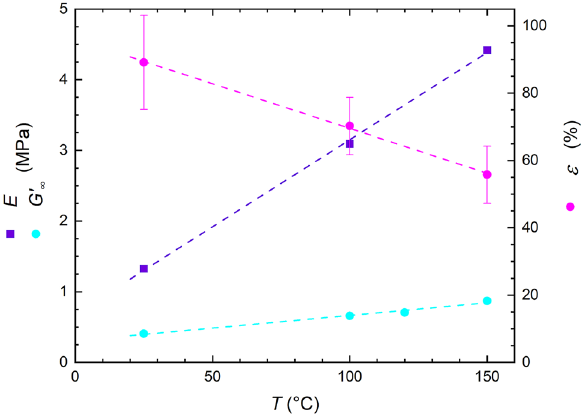
Figure 4. Impact of curing temperature on mechanical properties of neat Sylgard 184.